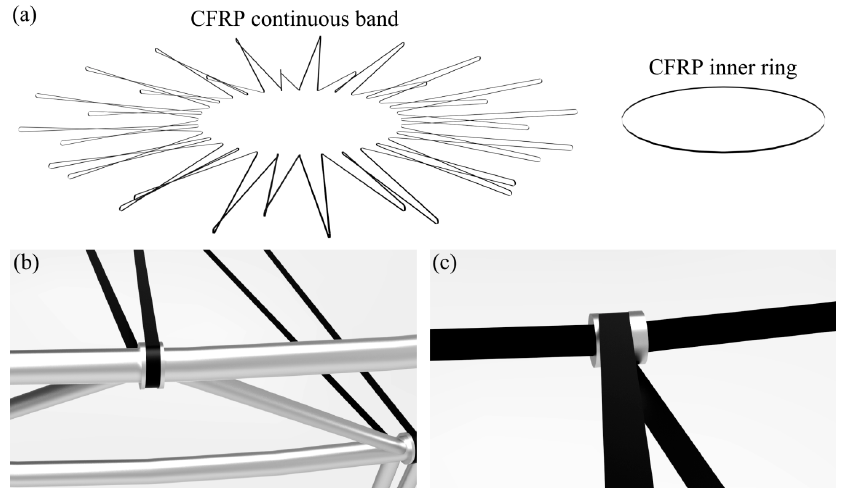
Figure 34. ( a ) CFRP continuous band used; ( b ) node at compression ring; and ( c ) node at tension ring.